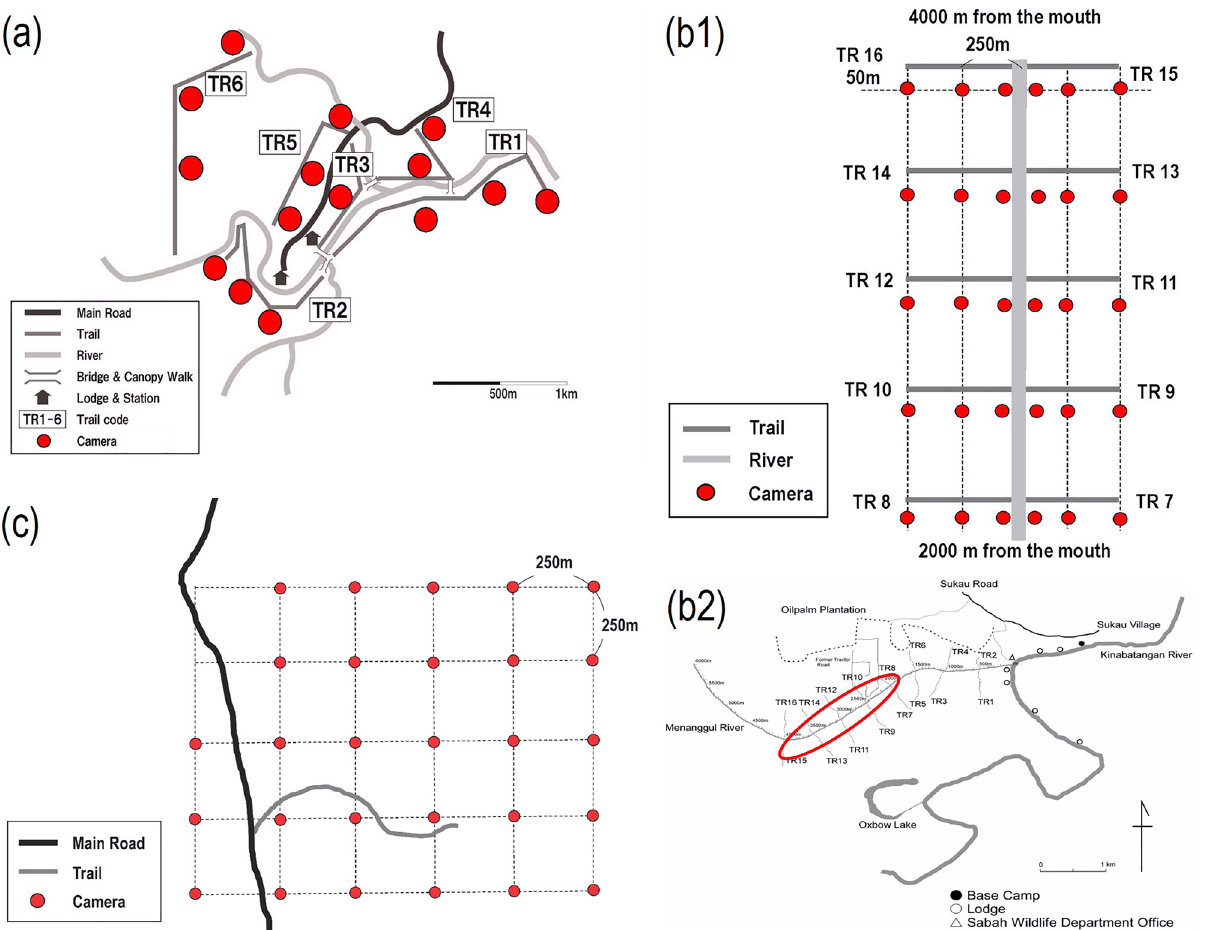
Figure 5. Maps of camera locations at each study site. ( a ) Trails and camera stations at DVCA; ( b1 ) trails and camera stations and ( b2 ) trail locations at LKWS; ( c ) a trail and camera stations at